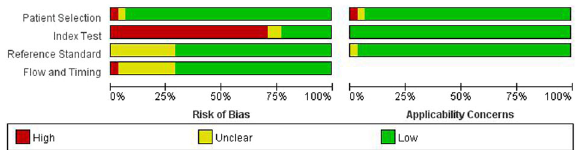
Fig. 3 Risk of bias and corresponding applicability concerns across included studies. Using QUADAS-2 tool. Key domains: patient selection; index test; reference standard; fl ow and timing. The risk of bias is indicated by three colors, red for high risk of bias, yellow for unclear risk of bias, and green for low risk of